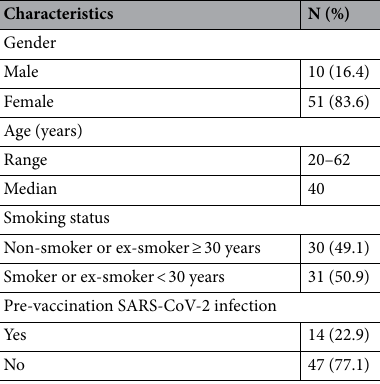
Table 1. Characteristics of study